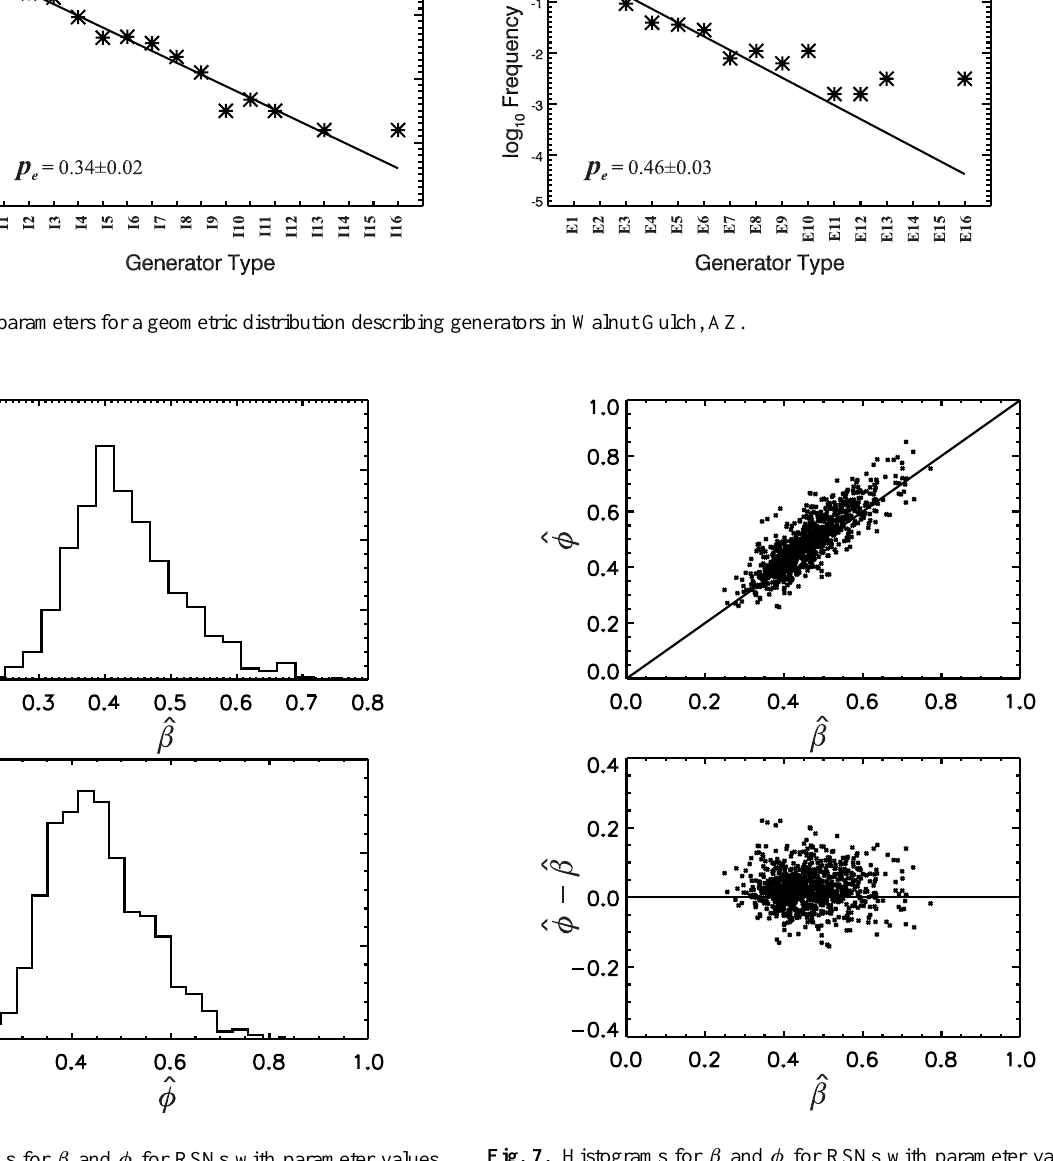
Fig. 6. Histograms for β and φ for RSNs with parameter values p i = 0 . 345 and p e = 0 . 462.